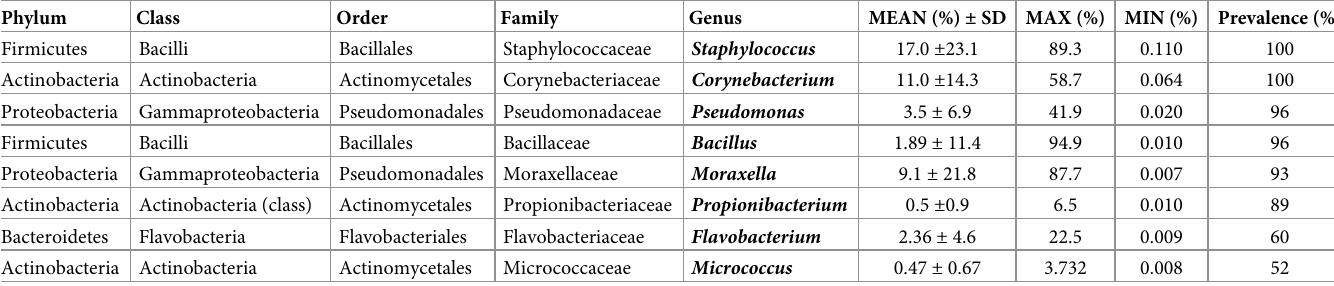
Table 3. Taxonomic profiling of bacterial community.